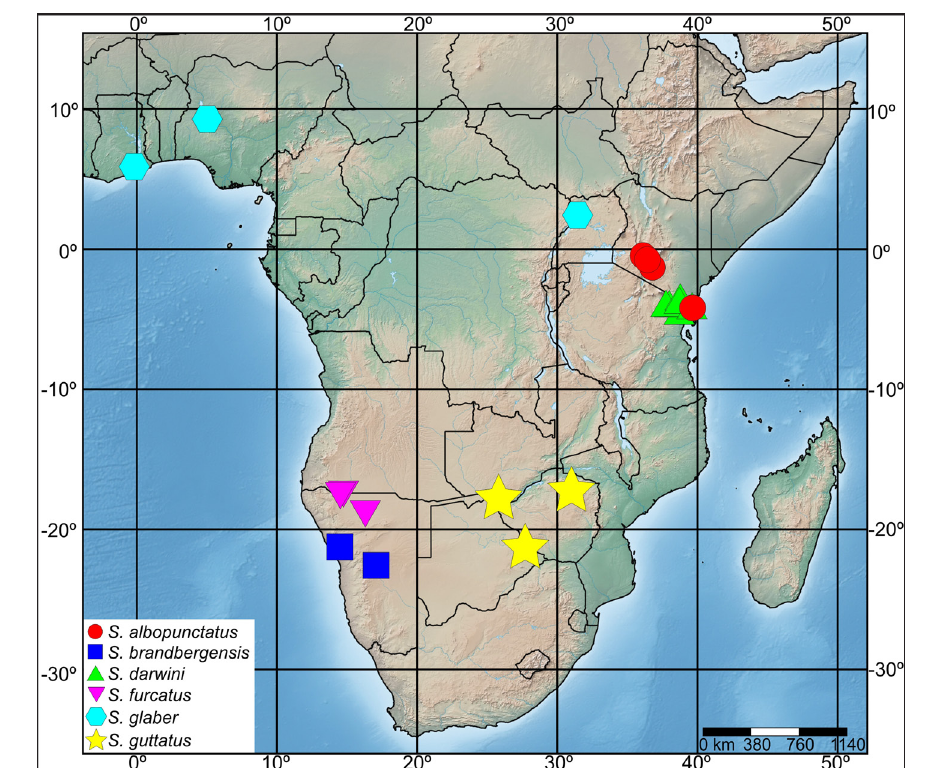
Fig. 511. Collecting localities of six African species of Stenaelurillus Simon, 1885.